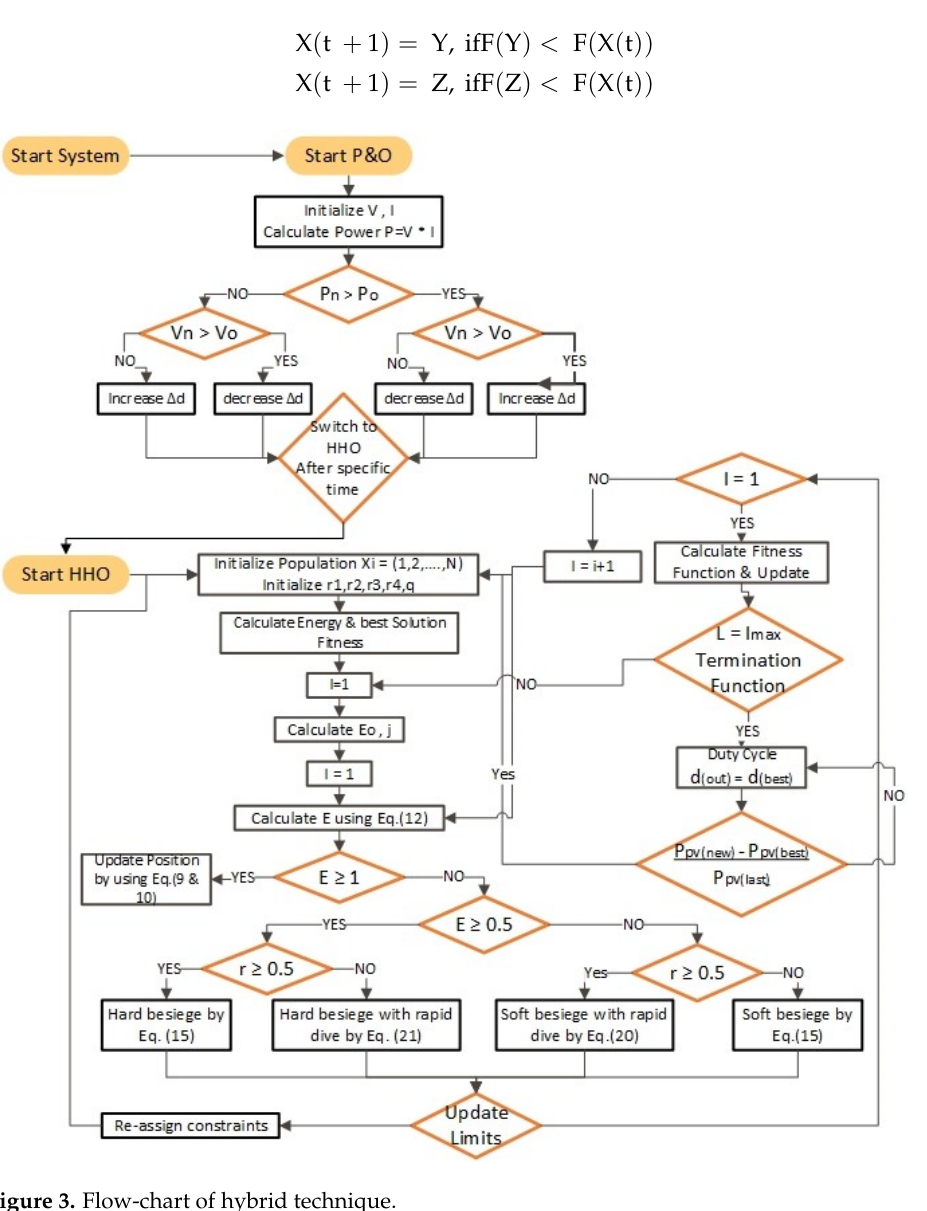
Figure 3. Flow-chart of hybrid